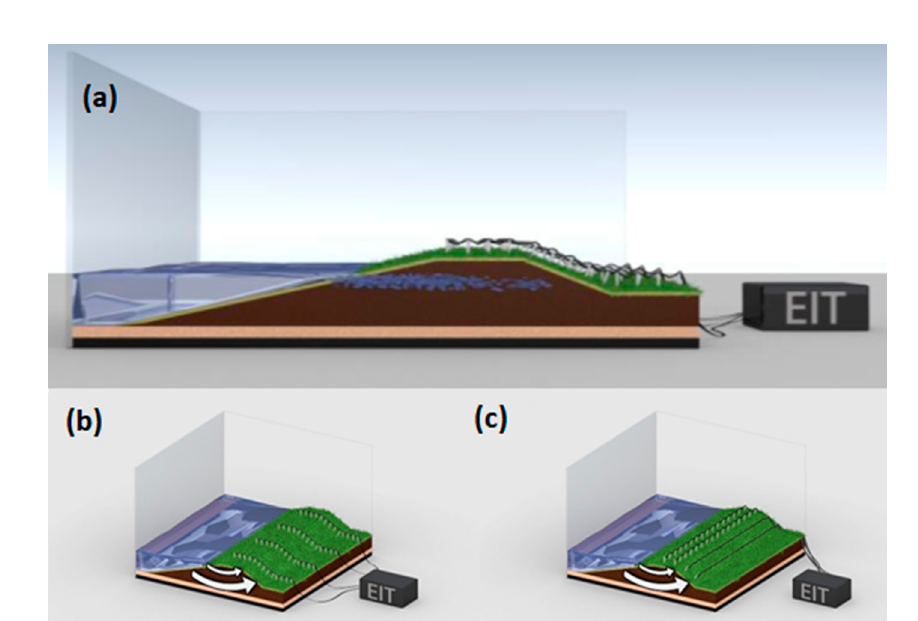
Figure 8. Geometrical model of embankment with EIT: ( a ) 2D, ( b ) 3D, ( c ) 3D.